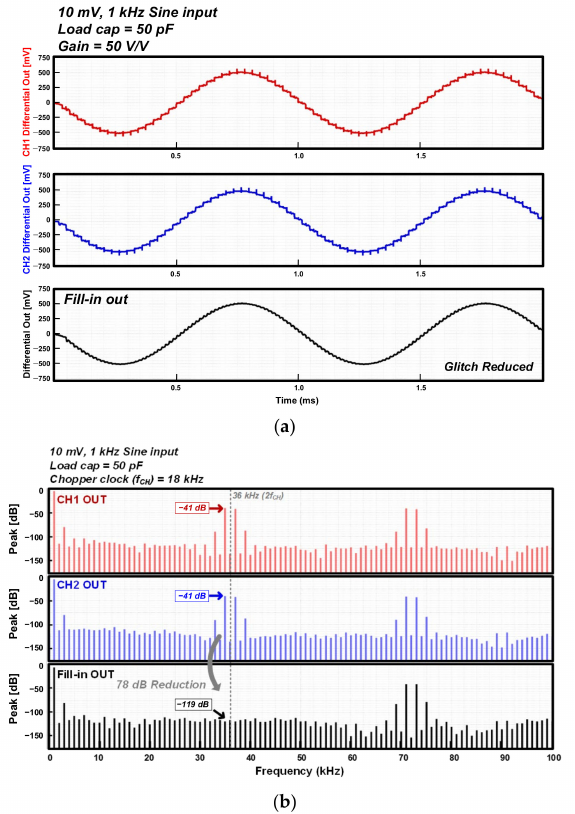
Figure 9. Glitch reduction simulation result for the proposed CFIA: ( a ) transient simulation result and ( b ) amplitude